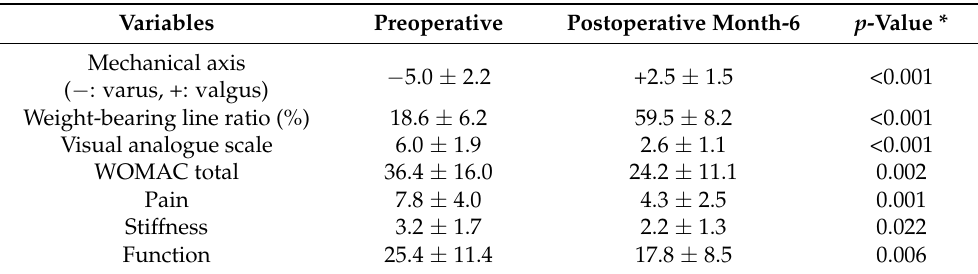
Table 7. Improvements in radiological and functional outcomes in 27 patients at 6 months af- ter